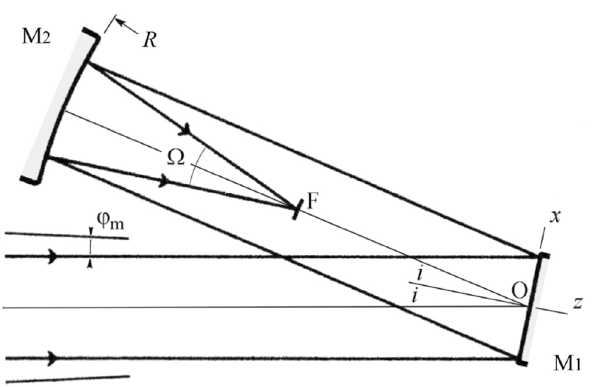
Figure 1: Schematic of a reflective two-mirror Schmidt telescope. The center of curvature of the spherical mirror M2 is located at the vertex of the plane-aspheric freeform mirror M1. The circular incident beams have circular cross-sections with an input pupil located at mirror M1. Deviation 2 i occurs at the principal rays. The semi-field maximum angle – here assumed to be circular – is denoted by φ